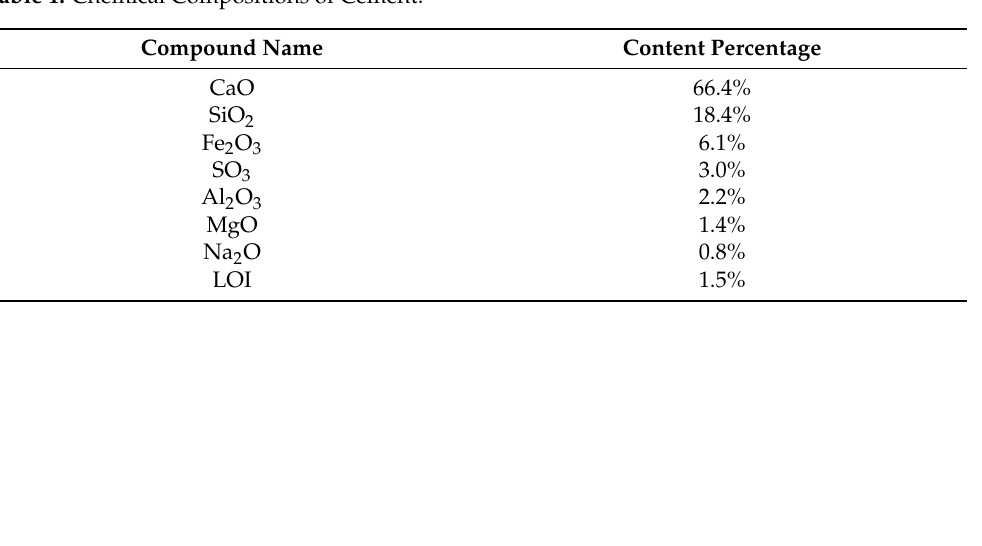
Table 1. Chemical Compositions of